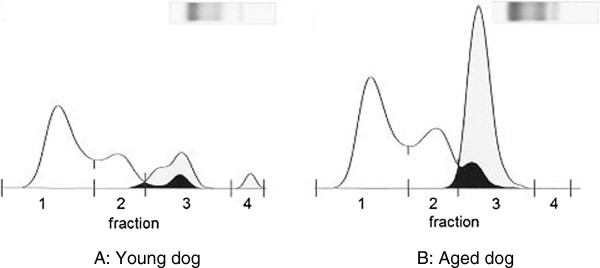
Gel electrophoresis and profiles for cholesterol lipoprotein and triglyceride lipoprotein. (A) young dog and (B) aged dog. White zones; cholesterol lipoprotein fractions Gray zones; triglyceride lipoprotein fractions. Black zones; cholesterol lipoprotein fractions and triglyceride lipoprotein fractions are piled up.